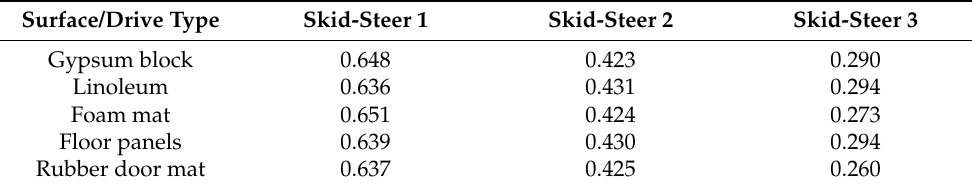
Table 6. The calculated steering efficiency coefficient χ for different robot and surface types. Surface/Drive Type